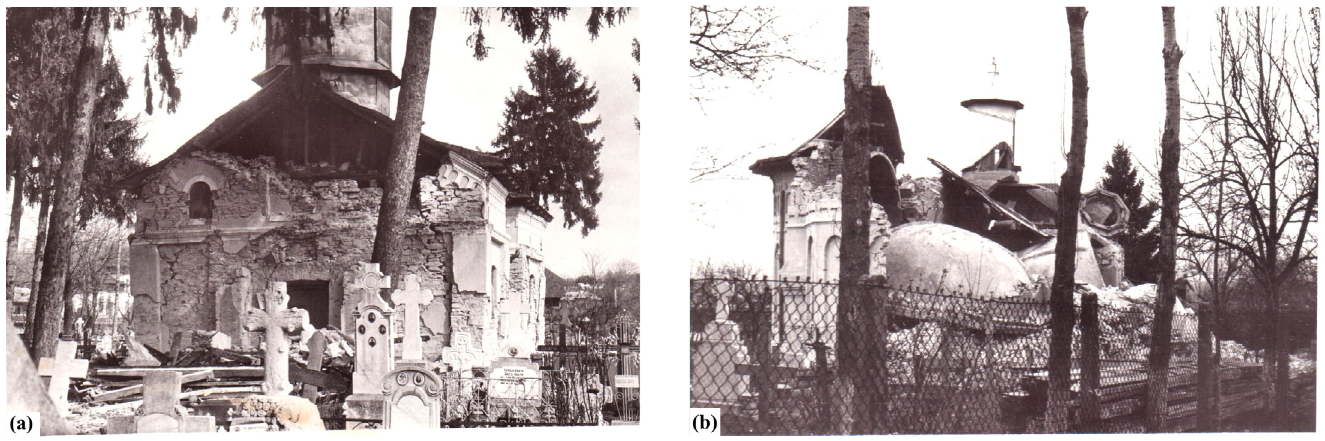
Figure 4. Masonry buildings destoyed in Prahova county. (a) Partial collapse of a church in Drajna (subsequently demolished). (b) Total collapse of a church in Boldesti (photos by Pantea [1979]).